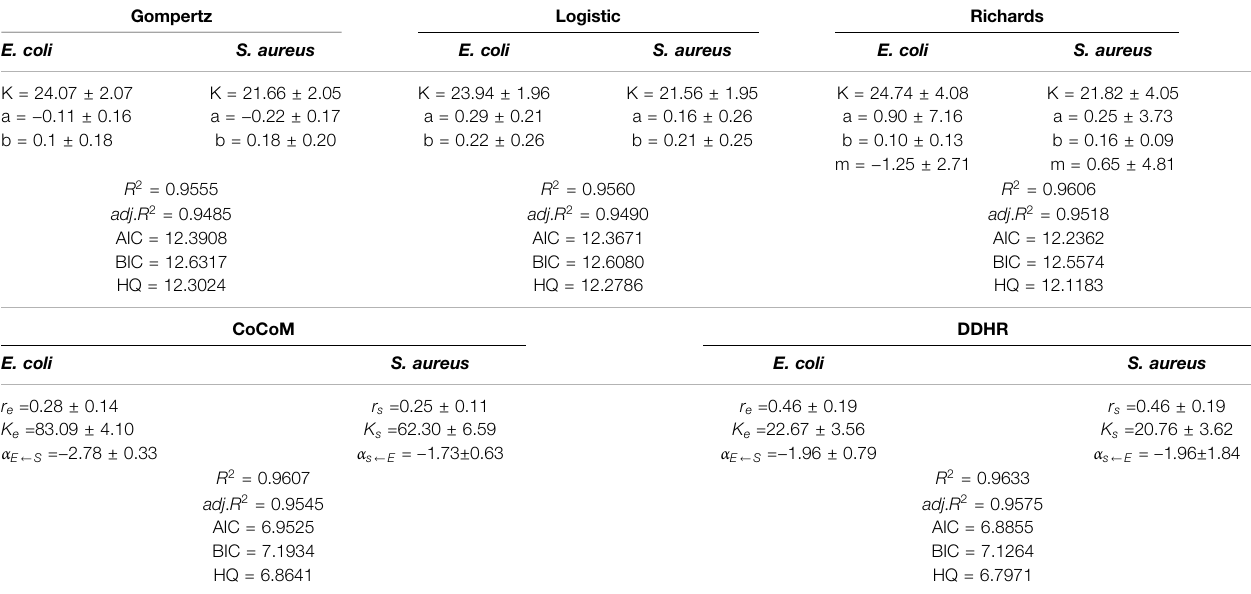
TABLE 1| Theestimated parametersofvarious growthequations,thegoodnessof fi t R 2 ,adjusted R 2 ,and theirevaluation informationbasedonakaikeinformationcriterion (AIC), bayesianinformationcriterion(BIC), andhannan-quinninformationcriterion(HQIC). Gompertz,Logistic,Richards,DDHR, andCoCoM models wereused to fi tthe average abundance of E. coli and S. aureus under